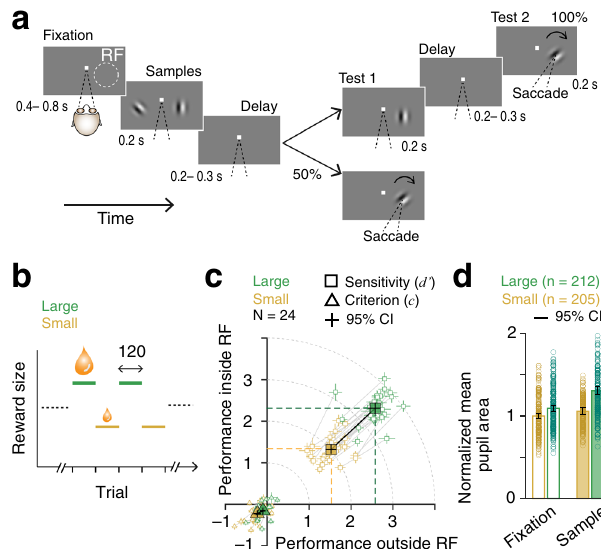
Fig. 2 Manipulation of attentional intensity using differential reward outcomes. a Visual spatial attention task. Monkeys were required to fi xate, attend to sample stimuli (Gabors) presented in both hemi fi elds (inside and outside of recorded neurons ’ receptive fi eld (RF)), and report an orientation change that occurred in one of the two test intervals by making a saccade to the stimulus location. b Unsignaled change in reward size between large and small values over blocks of 120 trials. c Attention operating characteristic (AOC) curve, indicating behavioral sensitivity ( d ′ , circles) and criterion ( c , triangles) on individual sessions and their average (solid markers) for test stimuli inside and outside RF during two reward conditions, large and small (24 Total sessions: 9 monkey P; 15 monkey S). Dashed colored lines indicate average d ′ in each hemi fi eld. Lines connect two reward conditions within a session. Data are presented as mean with 95% con fi dence intervals. d Block-averaged pupil area during pre-stimulus fi xation and sample stimulus periods. Pupil area was normalized to mean of pre-stimulus fi xation during small-reward trial blocks. Data are presented as mean with 95% con fi dence had appeared in that location (a target), the monkey had to rapidly make a saccade to the stimulus to earn a juice reward. On a random half of the trials, the orientation of test stimulus was unchanged (a nontarget) and the monkey was required to maintain fi xation. In that case, a second test stimulus that always had a different orientation was presented after a short delay and monkeys needed to saccade to this stimulus to earn a reward. both sides and fi xed, either small or large, within alternating blocks of 120 trials. Stimulus parameters remained unchanged size. The transitions between blocks were unsignaled and sequential (small to large or large to small, Fig. 2b). The monkey